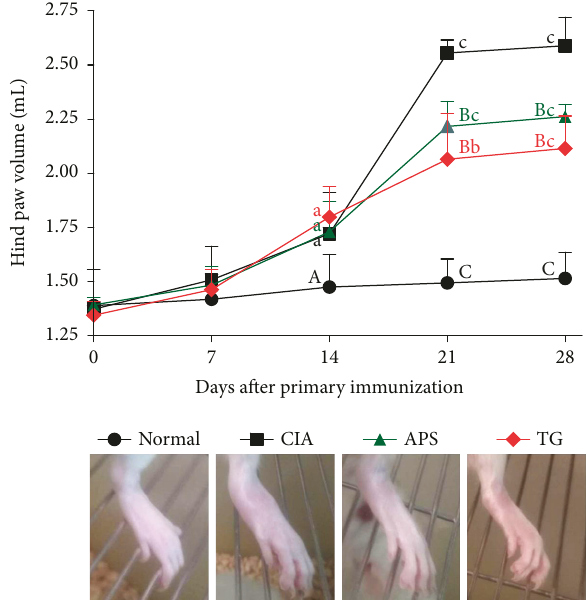
Figure 3: Paw volume evaluation before and after RA induction and drug administration. Data represent the mean ± SD of 6 rats per group. Signi fi cant e ff ect compared to the normal group: (a) P < 0 05 , (b) P < 0 01 , (c) P < 0 001 ; signi fi cant e ff ect compared to the CIA group: (A) P < 0 05 , (B) P < 0 01 , (C) P < 0 001